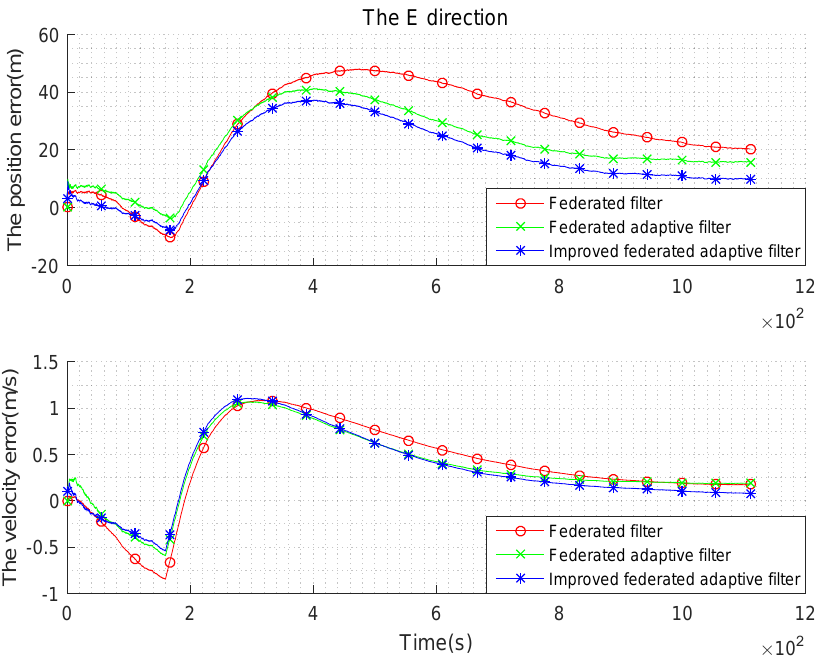
Figure 10. Comparison of the navigation error with non-Gaussian state noise and biased estimation in E direction.